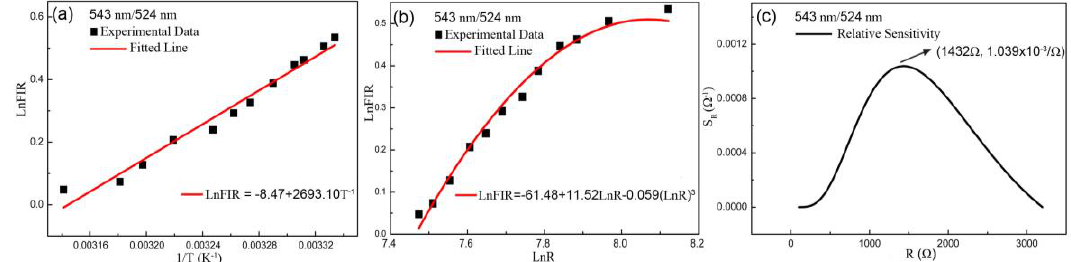
Figure 4. Plots of the ratio of 543 nm/524 nm including ( a ) the fitted curve of temperature-dependent FIR based on Boltzmann’s distribution law, ( b ) the fitted curve of resistance dependent FIR , and ( c ) the curve of resistance dependent relative sensitivity S R .